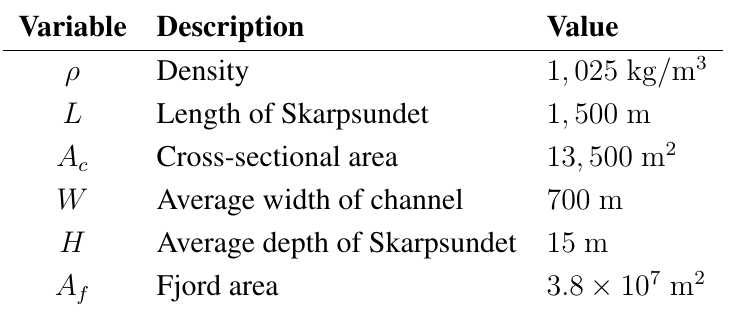
Table 1. Values for the Skarpsundet